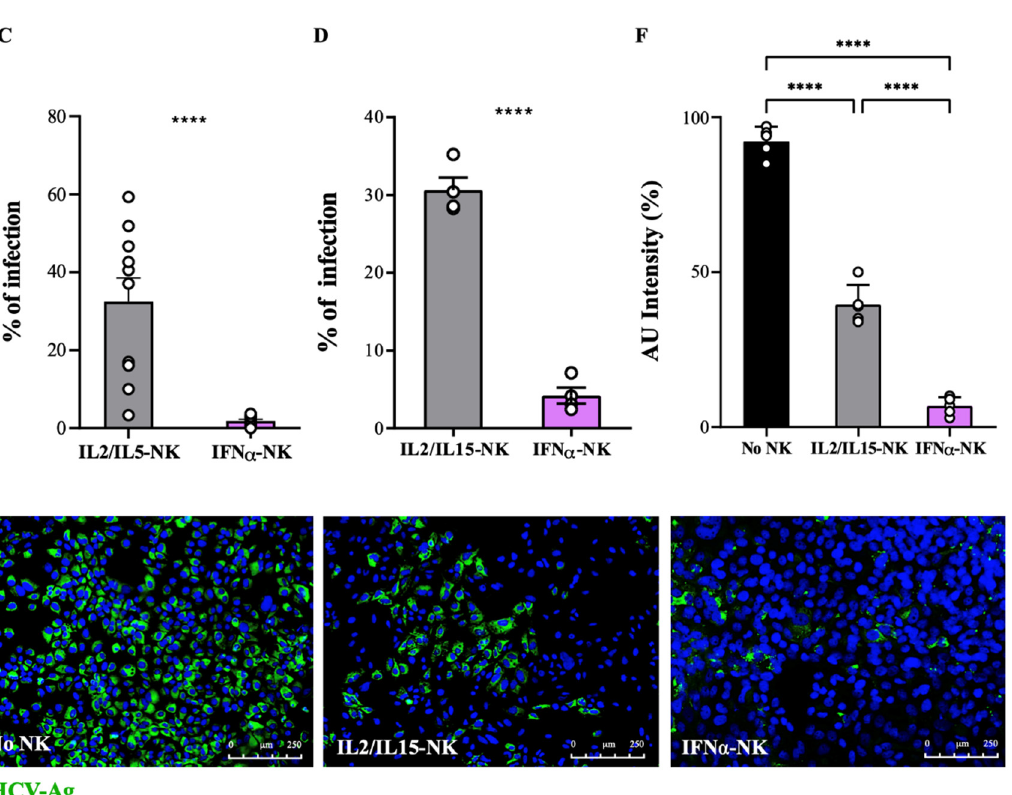
Figure 1. Functional characterization of NK cells activated with IL-2/IL-15 or IFN- α . ( A , B ) Percentage of lysed target HCV-Hu7.5 ( A ) or Huh7.5 ( B ) cells following exposure to decreasing ratios of IL2/IL15-NKs (gray bars) or IFN α -NKs (lilac bars), as calculated with a four-hour chromium release assay. Each dot represents the average of three technical replicates from one donor ( n = 6). Mean values ± SEM are shown. ( C ) Infection rates (percentage of control) of HCV-Huh7.5 cells exposed to IL2/IL15-NKs or IFN α -NKs using a transwell co-culture system. Infection rates were calculated by measuring HCV-Ag levels released in the culture media seven days after co-culture. Each dot represents the average of three technical replicates from one donor ( n = 10). Mean values ± SEM are shown. ( D ) Infection rates (percentage of control) of freshly plated Huh7.5 cells following exposure to medium conditioned with HCV-Huh7.5 cells that were co-cultured for seven days with IL2/IL15-NKs (gray bar) or IFN α -NKs (lilac bar). Each dot represents the average of three technical replicates from one donor ( n = 4). Mean values ± SEM are shown. ( E ) Representative immunofluorescence staining of HCV-Ag (green color) in HCV-Huh7.5 cells seven days after co-culture with IL2/IL15-NKs ( middle image ) or IFN α -NKs ( right image ). Untreated cells were used as controls ( left image ). DAPI (blue color) was used to stain the nuclei. Magnification of 200 × . ( F ) Intensity of fluorescent HCV-Ag signal in cells as in ( E ), expressed as arbitrary units (AU), as quantified with ImageJ software. Each dot represents the average of three technical replicates from one donor ( n = 5). Mean values ± SD are shown. Statistical analyses were performed using a two-way ANOVA with the Š í d á k multiple comparison test ( A , B ), unpaired Student’s t -test ( C , D ), and the one-way ANOVA with Tukey’s multiple comparisons test. * p < 0.05, ** p < 0.01, **** p < 0.0001; n.s.,